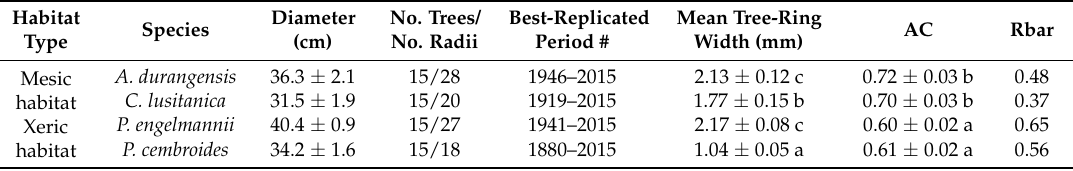
Table 1. Dendrochronological statistics of the sampled sites and tree species considering the common interval 1955–2015 (except for the best replicated